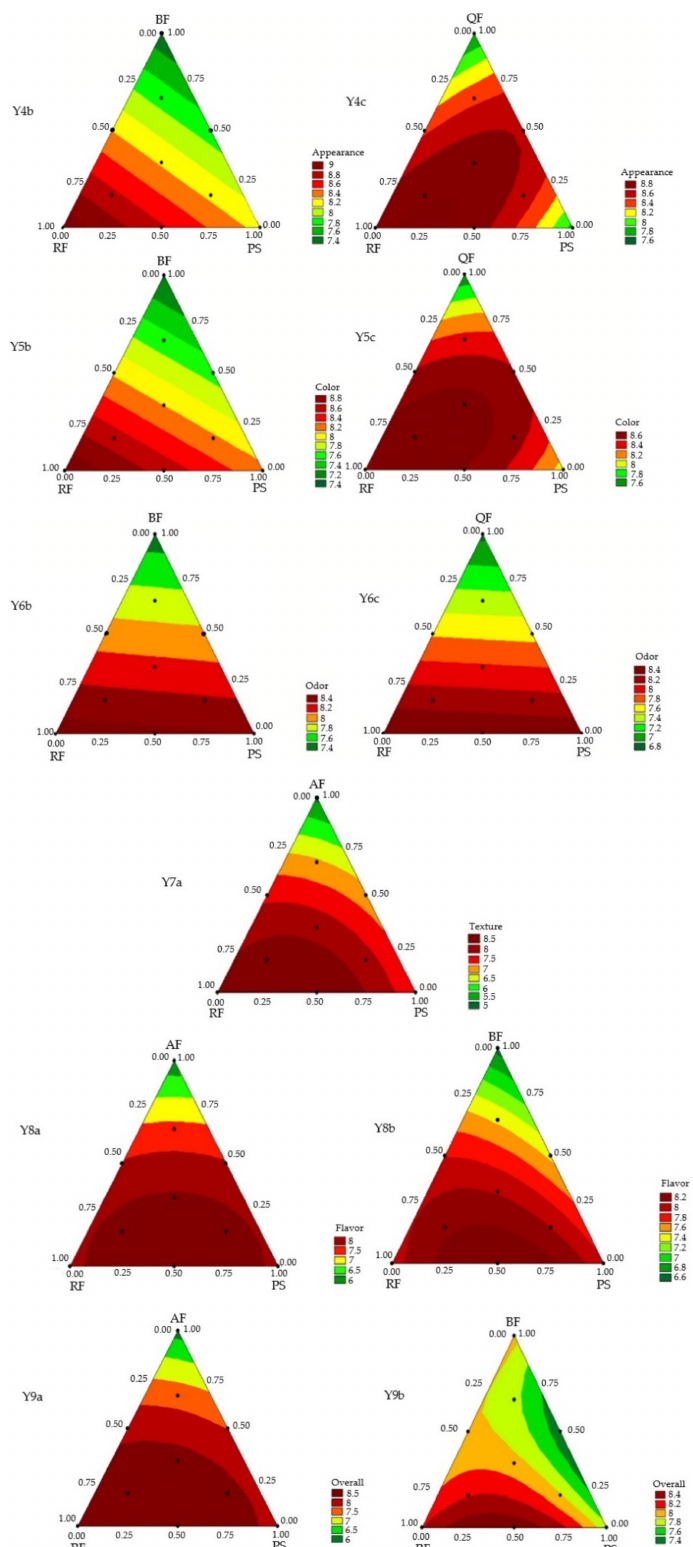
Figure 2. Contour plots from the predict model equations for the sensory acceptability scores (10-cm hybrid hedonic scale) of the gluten-free breads based on a mixture design. Formulation ID: AF—amaranth flour; BF—buckwheat flour; QF—quinoa flour; RF- rice flour; PS—potato